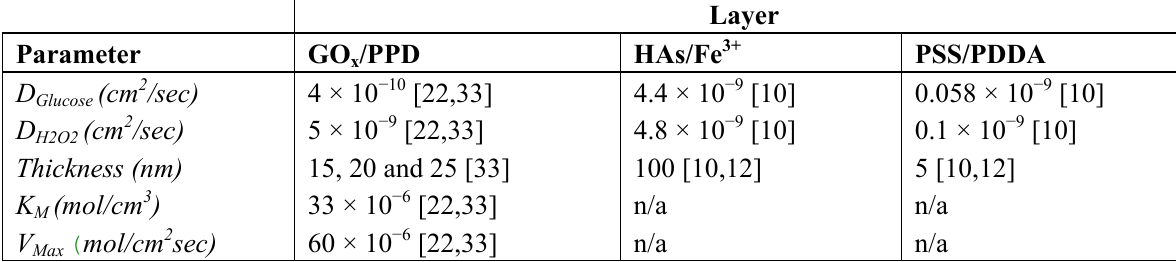
Table 2. Physical parameters for the enzyme layer and LBL assembled outer membrane used in the simulation, including diffusion coefficients for glucose and H thicknesses, Michaelis-Menten constant and maximum rate of enzymatic